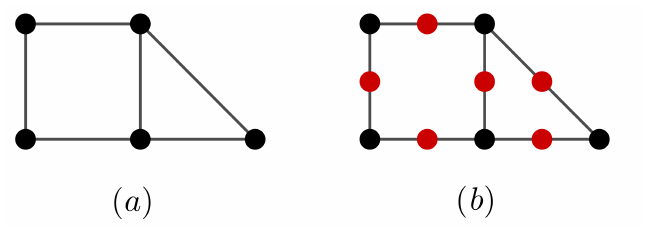
Figure 4. In ( a ) a graph G, in ( b ) graph Q ( G )